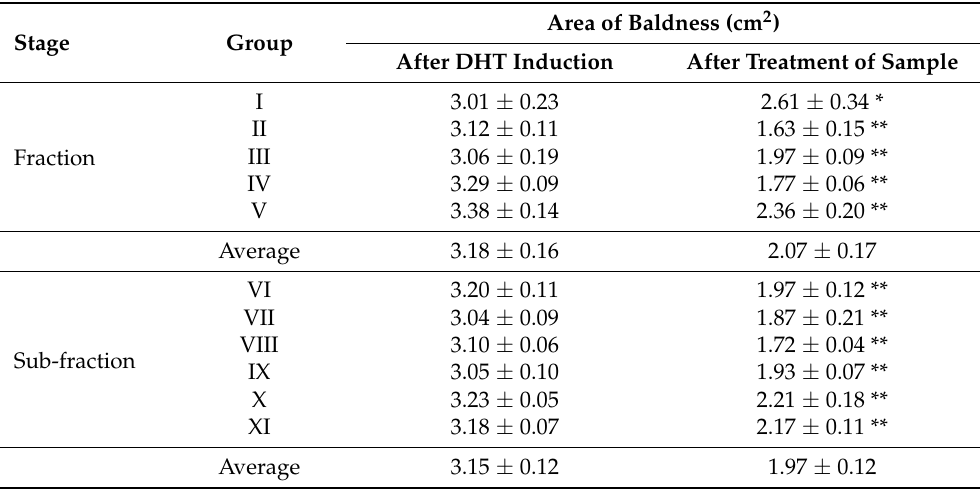
Area of Baldness (cm 2